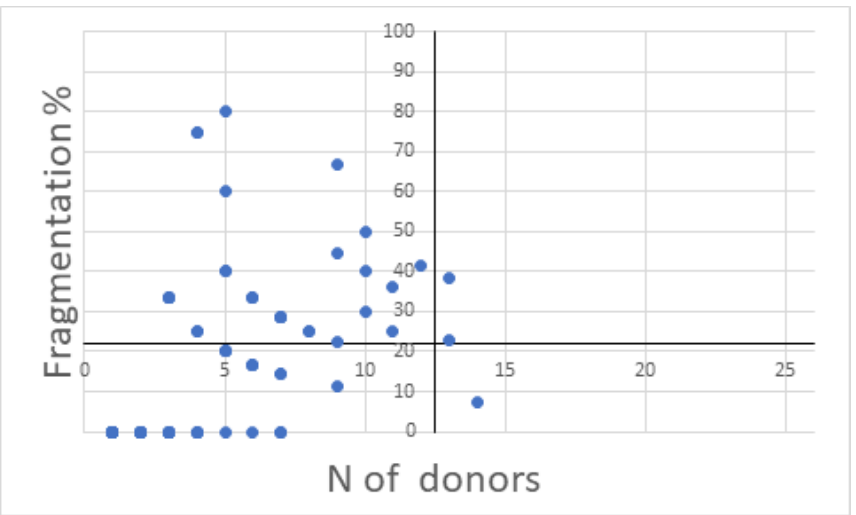
Figure 1. Relationship between the number of donors and fragmentation rate in recipient REDD+ countries.